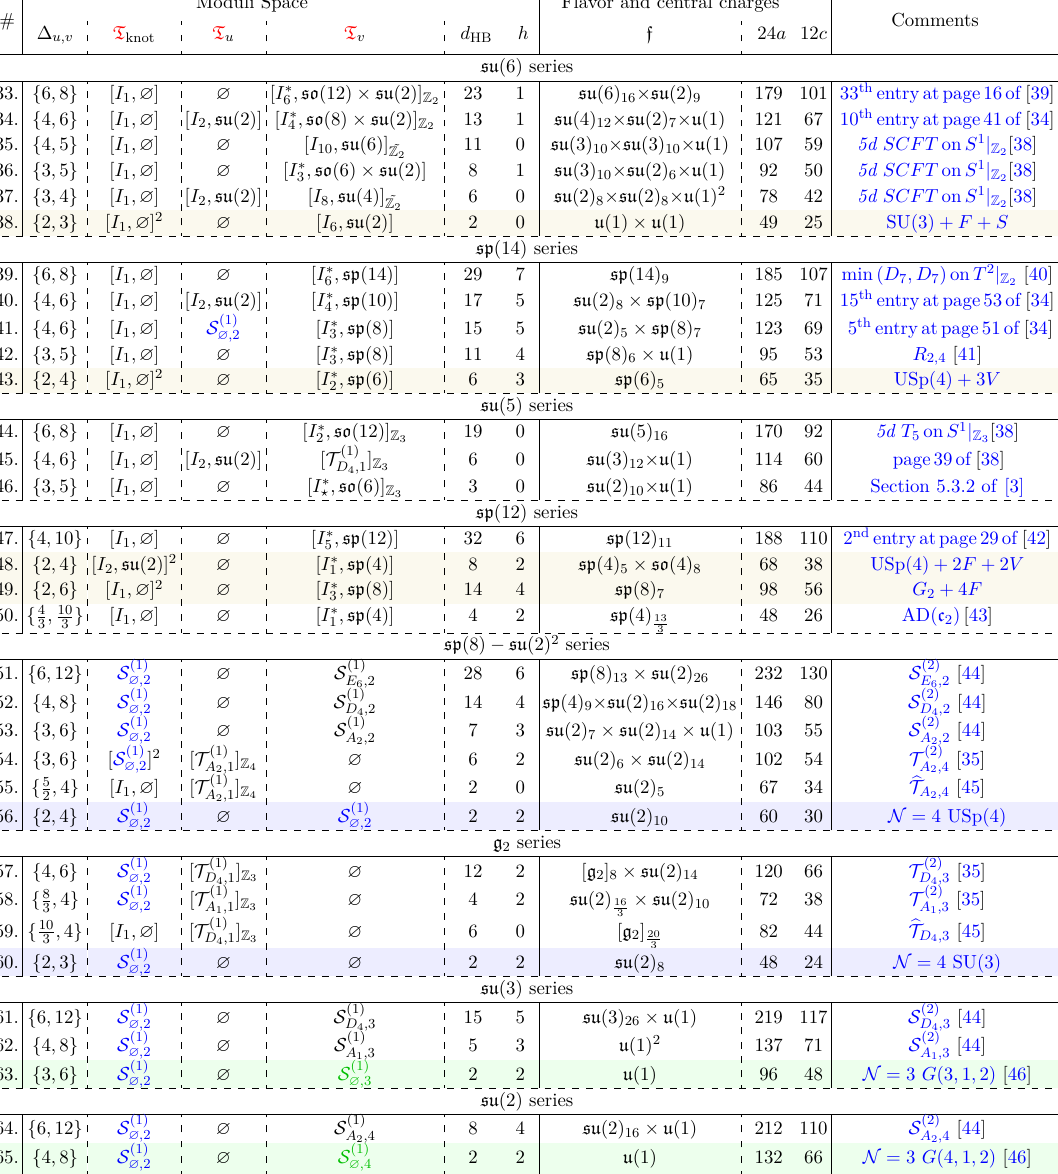
Table 2. Second part of the list of rank-2 theories organized by series . Theories in each series are mutually connected by mass deformations. The second column lists the scaling dimension of the CB parameters. Columns 3, 4 and 5 instead list the rank-1 theories describing the massless states on the connected components of the CB singular locus, see table 4 for how to read these entries. The Z subscript indicates discrete gauging. Continuing, d indicates the quaternionic dimension ‘ HB of the HB while h that of the ECB. Column 8 indicates the flavor symmetry of theory, along with the level, followed by the a and c central